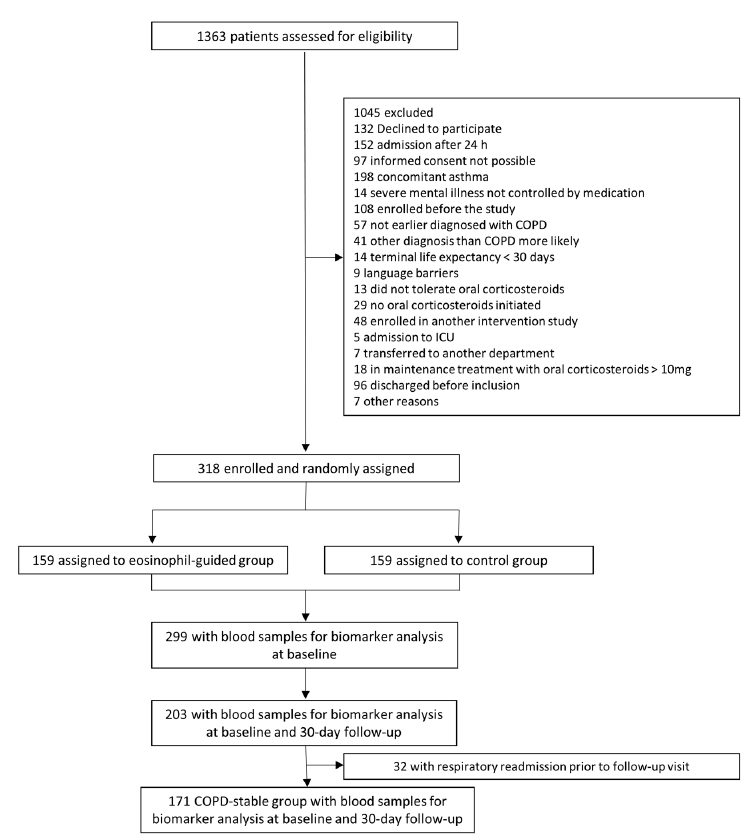
Figure 1. Study flowchart.